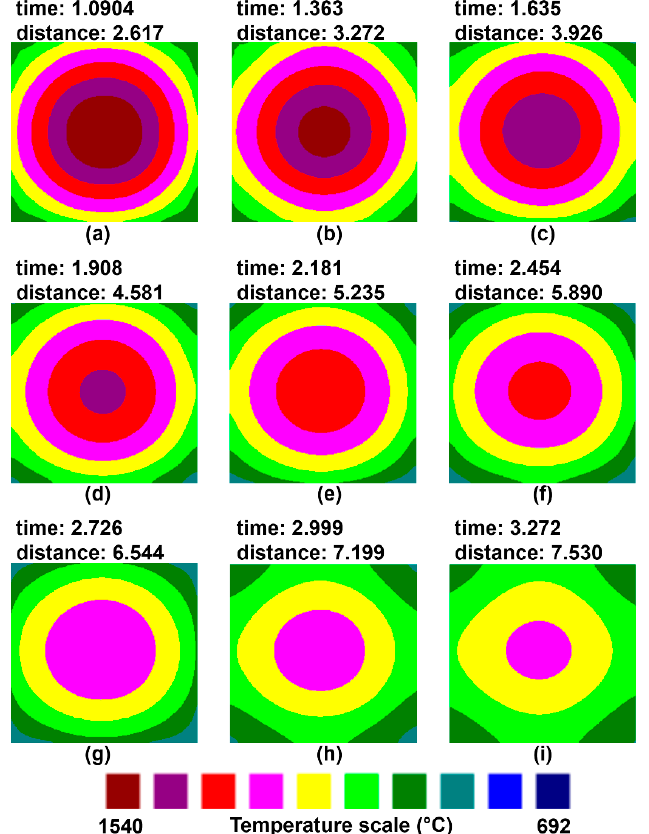
Figure 10. ( a – i ) Temperature profiles in the SCS. Here, the temperatures’ profiles became non-sym- metrical due to different water flows rates applied to quench every side; time (min) and distance (m).